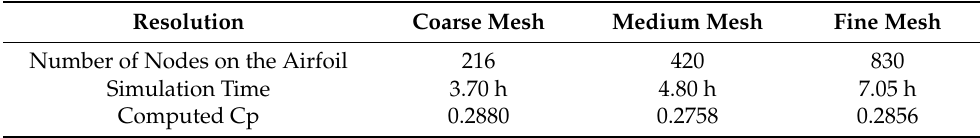
Table 1. Summary of the computed Cp for different node